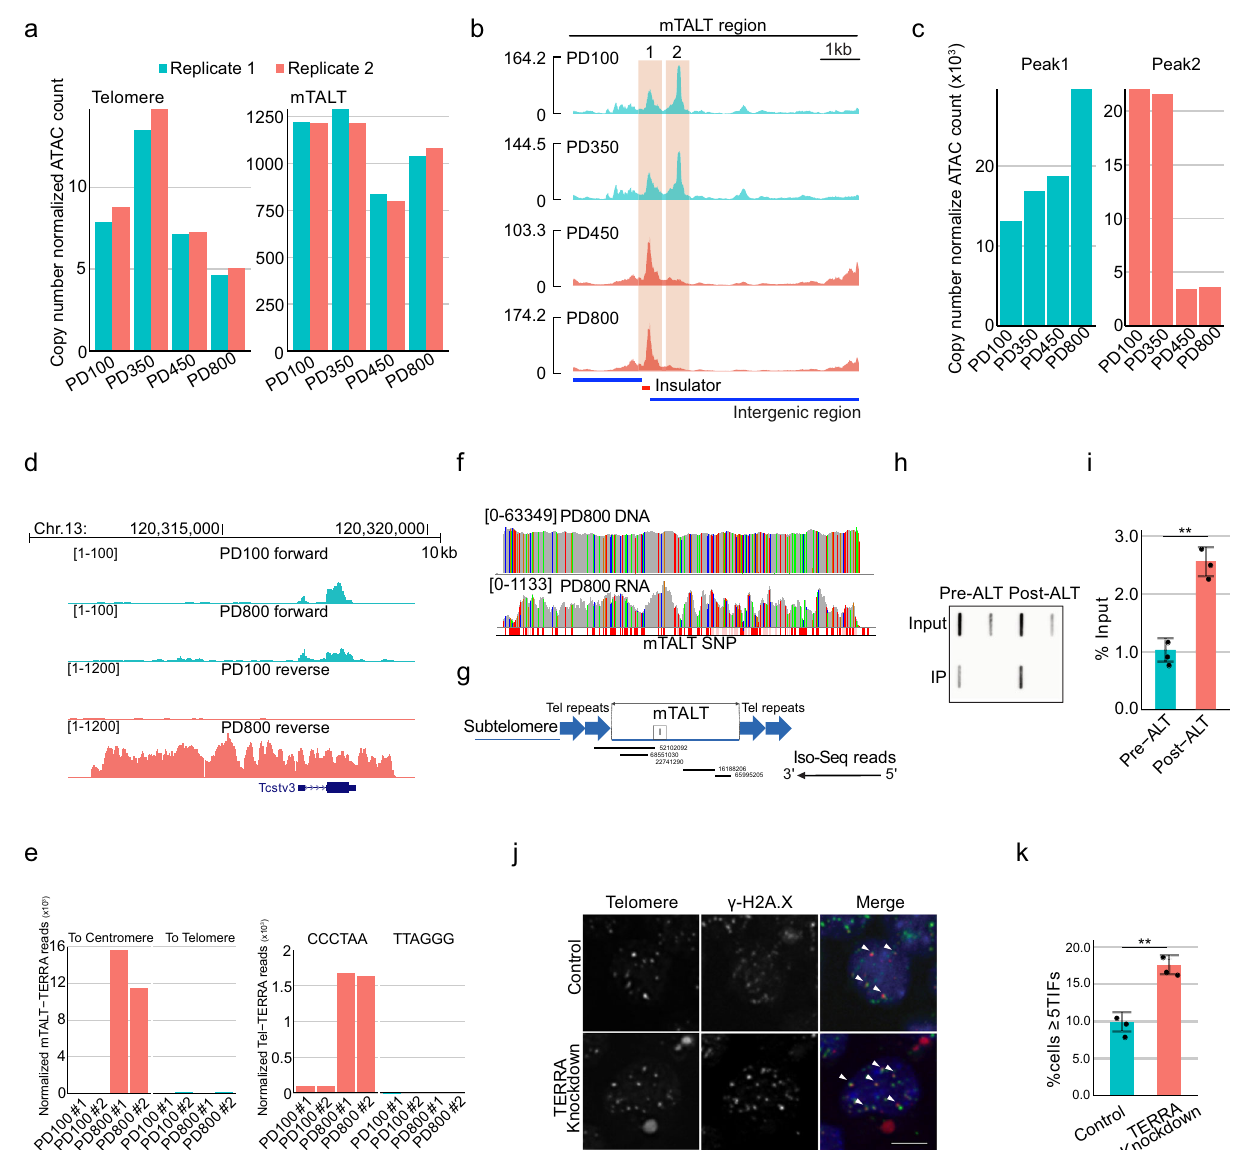
Fig. 4 Long non-coding RNA transcribed from ALT telomeres is important for telomere maintenance in ALT mESCs. a Copy number normalised ATAC- seq counts mapped to telomere and mTALT regions. b mTALT region snapshot of ATAC-seq peaks. c Quanti fi cation of ATAC-seq peaks mapped to speci fi c peaks inside mTALT in b . d Snapshot of RNA-seq of the mTALT region. ‘ Forward ’ and ‘ reverse ’ denote the transcription directions. e Calculated levels of mTALT-containing (left) and telomeric repeat-containing transcripts (right) according to the transcriptional direction. f Snapshot of the SNPs of mTALT genomic sequences and transcripts. g Iso-Seq reads aligned to the mTALT region. The right ends of all reads are 5 ʹ . I insulator. h Representative fi gure of the slot-blot with a telomere-speci fi c probe for the DRIP assay. Input DNA was loaded at a 1/10 dilution. i Quanti fi cation of slot-blot results. The bars represent the means and SDs from three biologically independent replicates. P value from a two-tailed unpaired t -test: ** P = 0.0012. j Representative images of interphase-TIF analysis. Scale bar, 5 μ m. k Quanti fi cation of the ratio of cells with more than fi ve TIFs. The bars represent the means and SDs from three biologically independent replicates. P values from a two-tailed unpaired t -test: ** P = 0.0018. Source data are provided as a Source Data fi